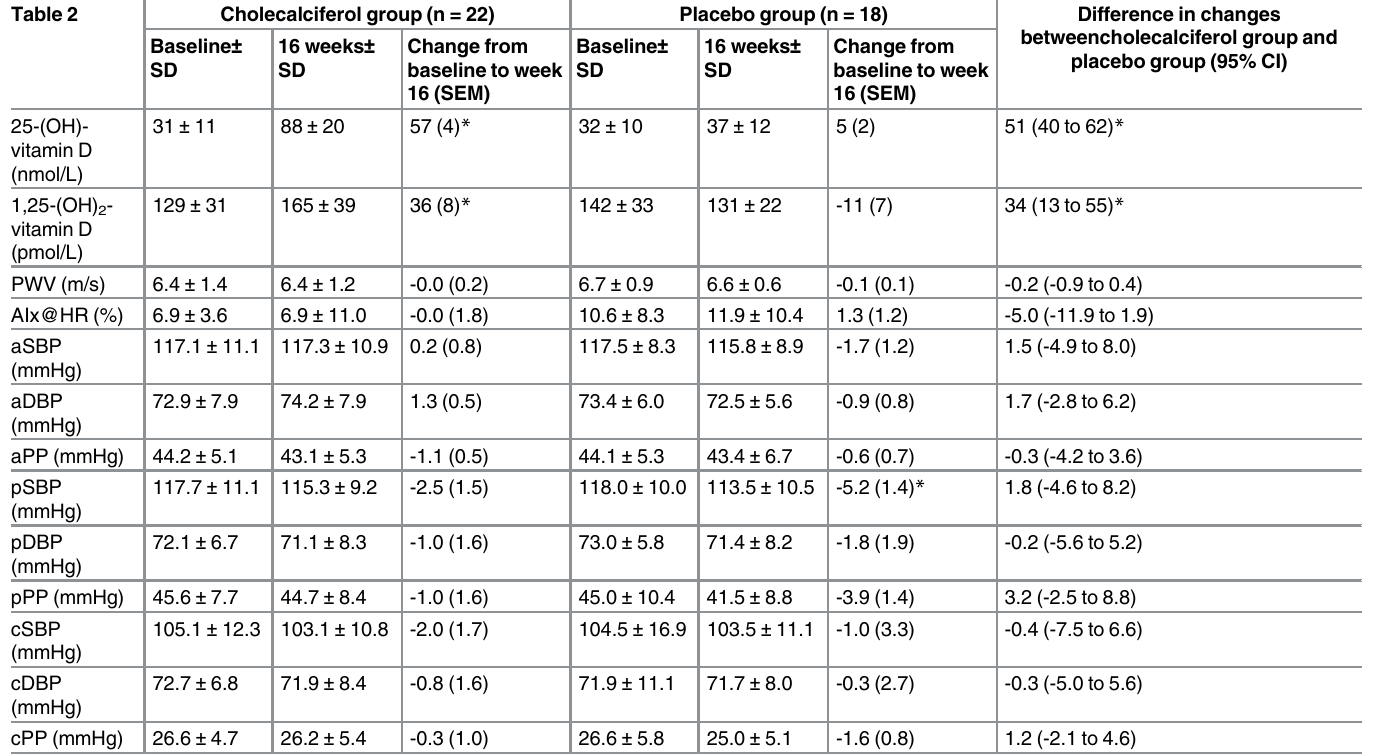
Table 2. Results of Cholecalciferol Treatment versus Placebo. Table 2 Cholecalciferol group (n = 22) Placebo group (n = 18) Difference in changes